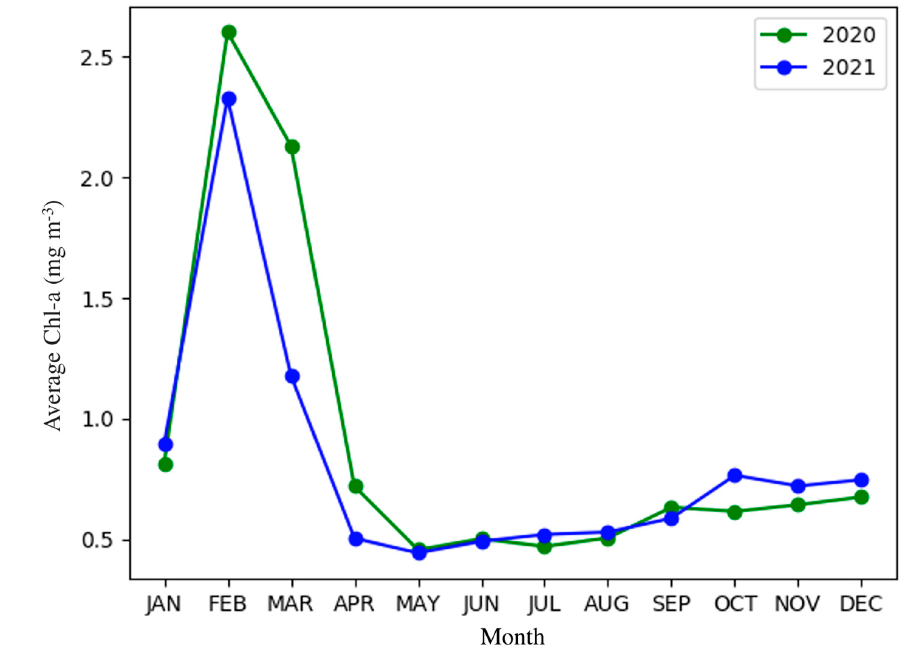
Figure 14. Monthly average Chl − a values in 2020 and 2021.